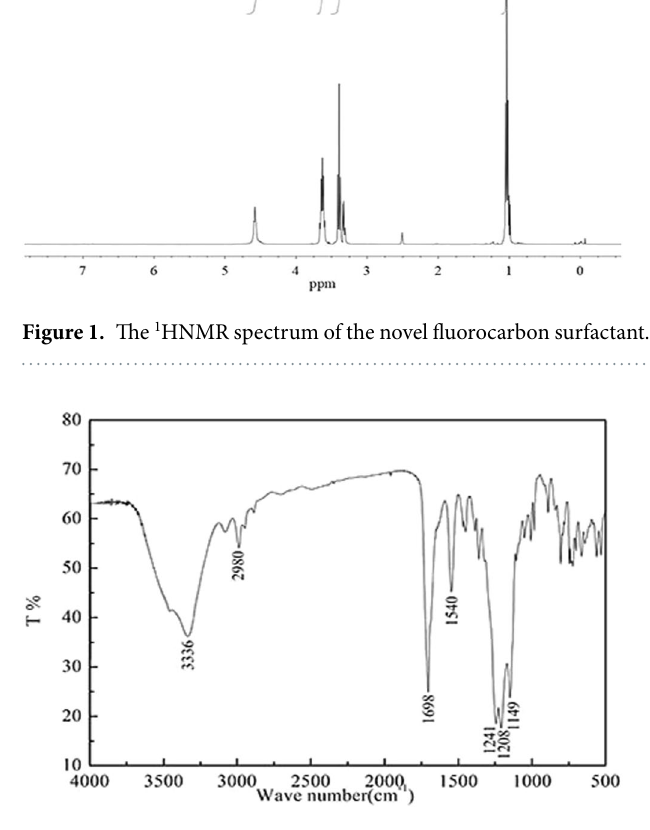
Figure 2. FTIR spectra of the novel fluorocarbon